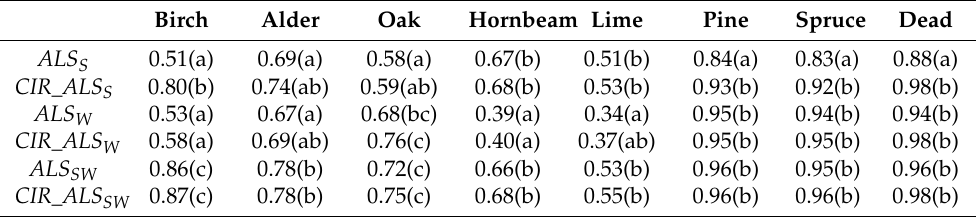
Table 5. F1-scores of the classification results for different sets of features. Letters “a, b, c” identify groups with no significant differences (based on McNemar’s tests). The ALS is the point cloud from the leaf-on (S) or/and leaf-off (W) season, whereas the CIR is the spectral information derived from the colour-infrared images. Birch Alder Oak Hornbeam Lime Pine Spruce